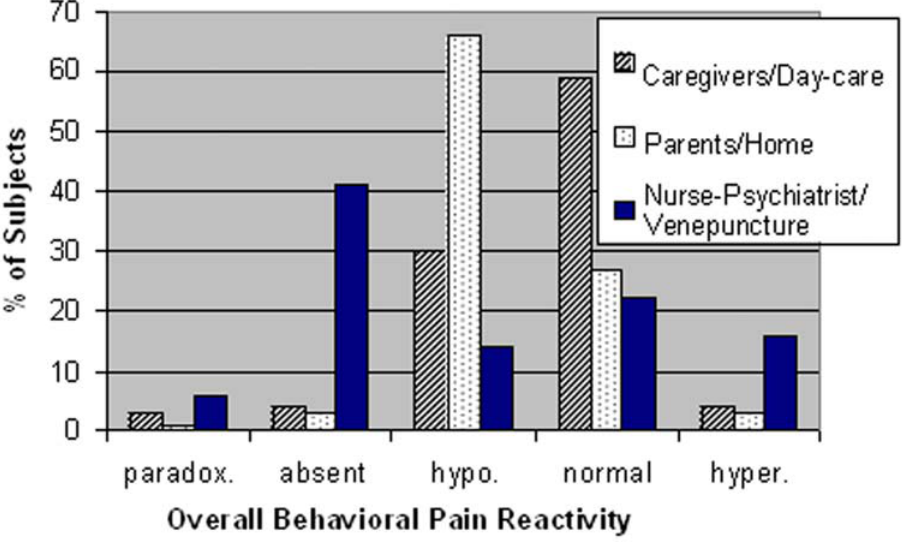
Figure 1. Overall Behavioral Pain Reactivity in Autism According to Rater/Setting. Types/classes of pain reactivity are described in detail in Table 3 and the numerical data are presented in Table